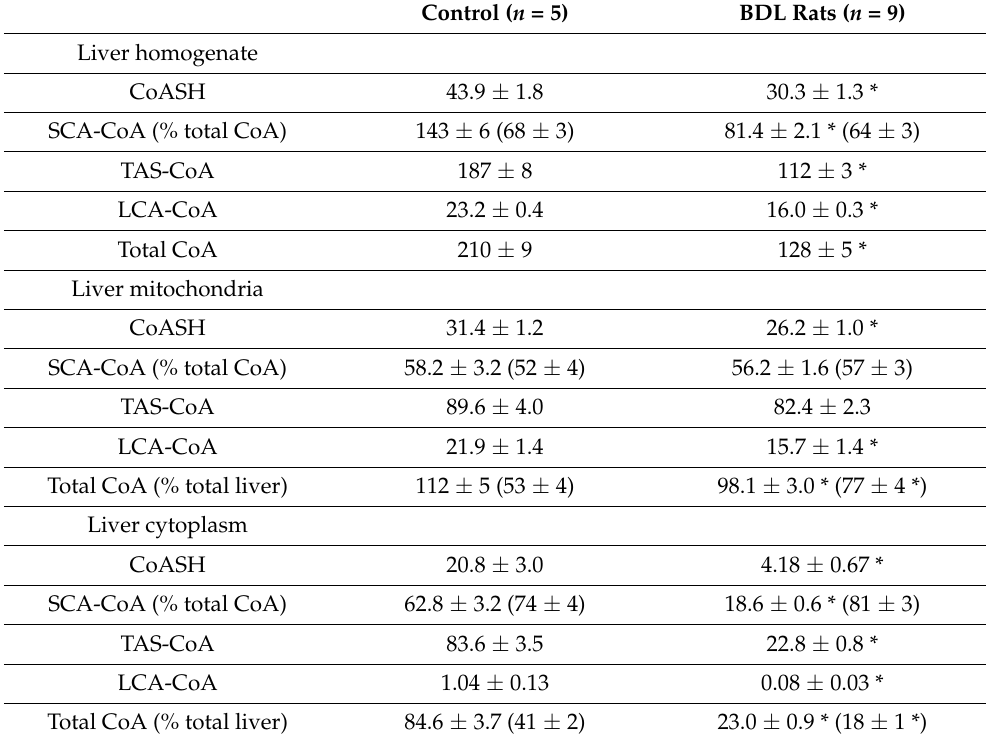
Table 2. CoA content per g of liver wet weight in liver homogenate, cytoplasm and mitochondria. Control ( n = 5) BDL Rats ( n =